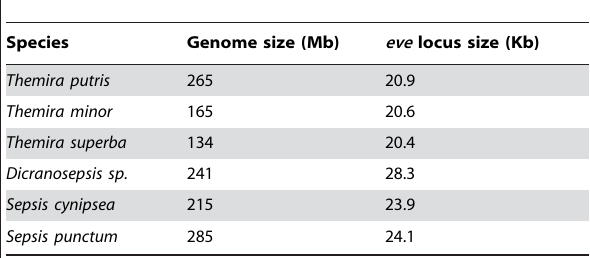
Table 1. Genome and eve locus size in sepsids.